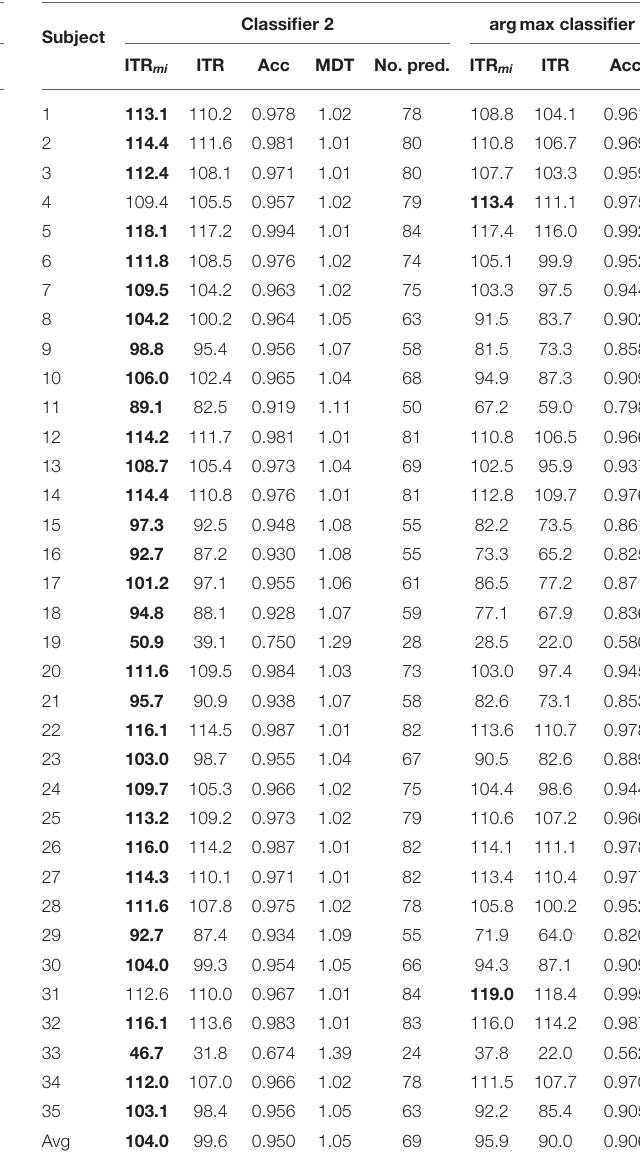
TABLE 5 | Classifier 2 compared with the arg max classifier using three classes.